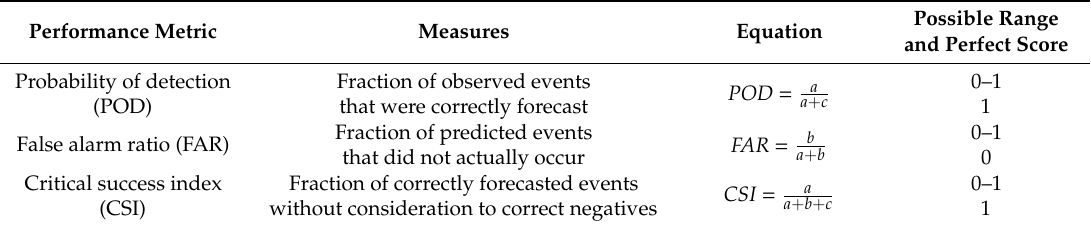
Table 2. Forecast metrics calculated in this